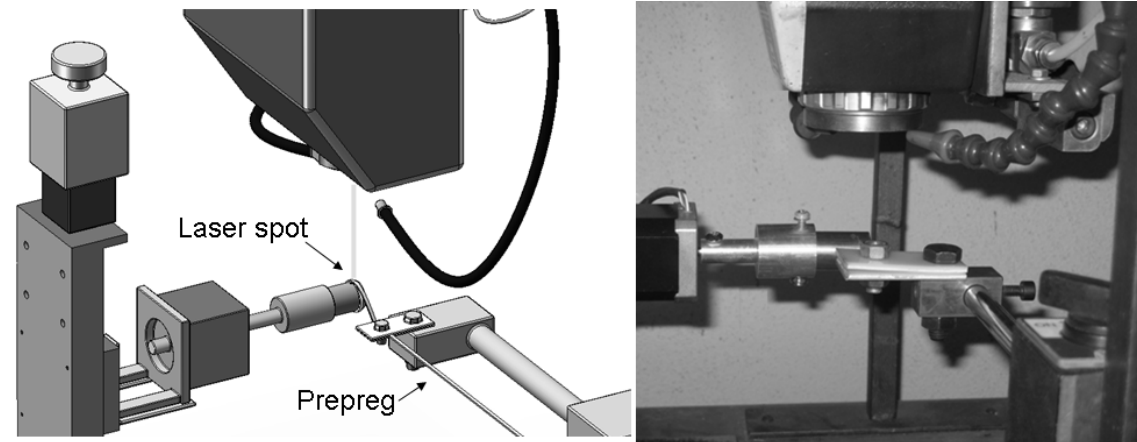
Figure 2. A detail of the consolidation